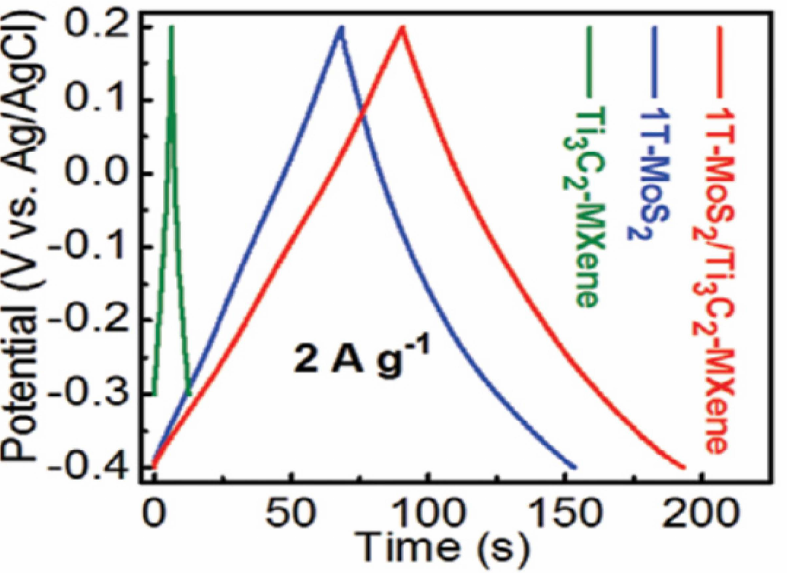
Figure 9. GCD curves 1T-MoS 2 , Ti 3 C 2 MXene. Reproduced with permission from [88]. Copyright 2022